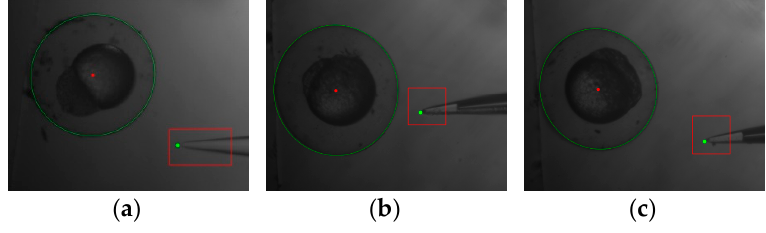
Figure 10. The results of image processing. ( a ) Embryo 1; ( b ) Embryo 2; ( c ) Embryo 3.